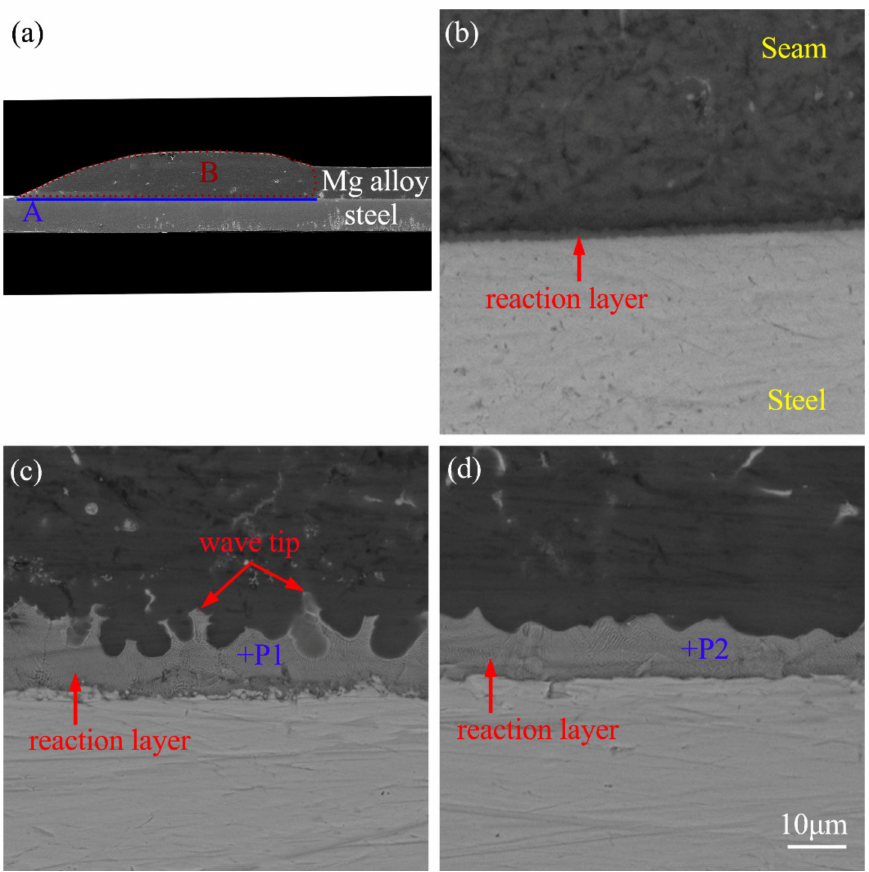
Figure 6. The typical backscattered electron (BSE) micrographs of the brazing area: ( a ) cross-sectional macrostructure; ( b ) current of 55 A, ultrasonic power of 0 kW; ( c ) current of 65 A, ultrasonic power of 0 kW; ( d ) current of 65 A, ultrasonic power of 0.9